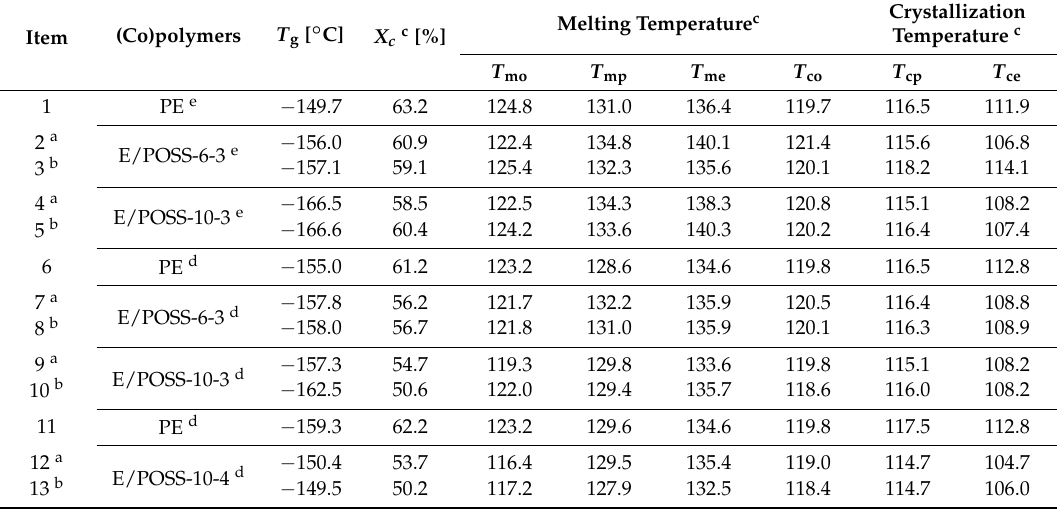
Table 2. Thermal properties of PE and E/POSS copolymers synthesized over the rac -Et(Ind) 2 ZrCl 2 /MMAO catalytic system.